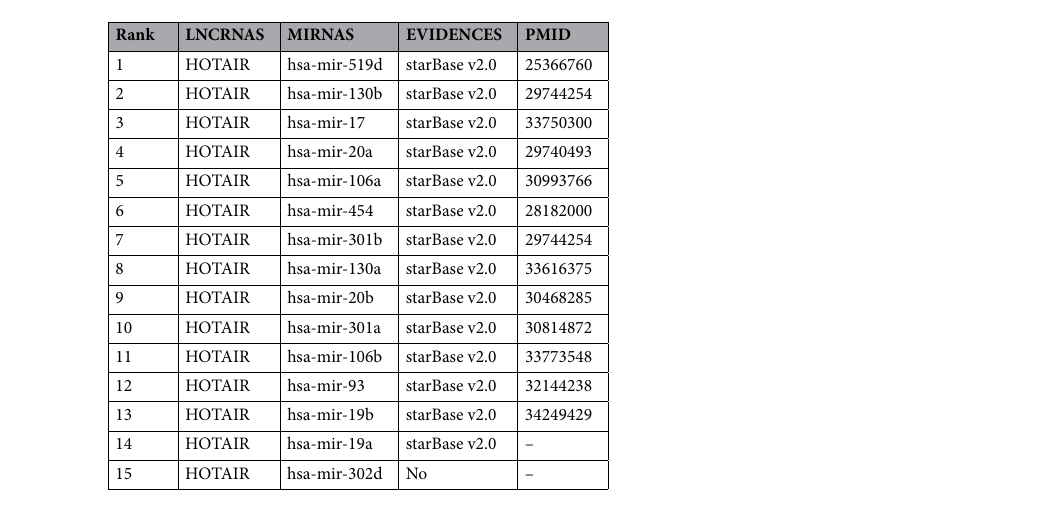
Table 7. The top 15 candidate miRNAs for